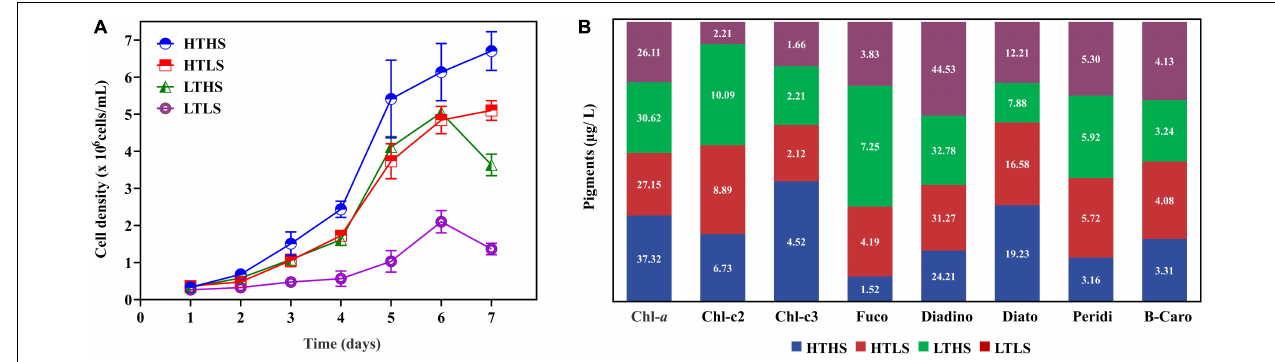
FIGURE 1 | (A) Cell density in four different conditions. HTHS, high silicate high temperature; HTLS, high silicate low temperature; LTHS. low-temperature high silicate; LTLS, low-temperature low silicate. The error bars represent the standard errors from triplicate measurements and (B) , the observed pigment composition in Skeletonema dohrnii under different stress